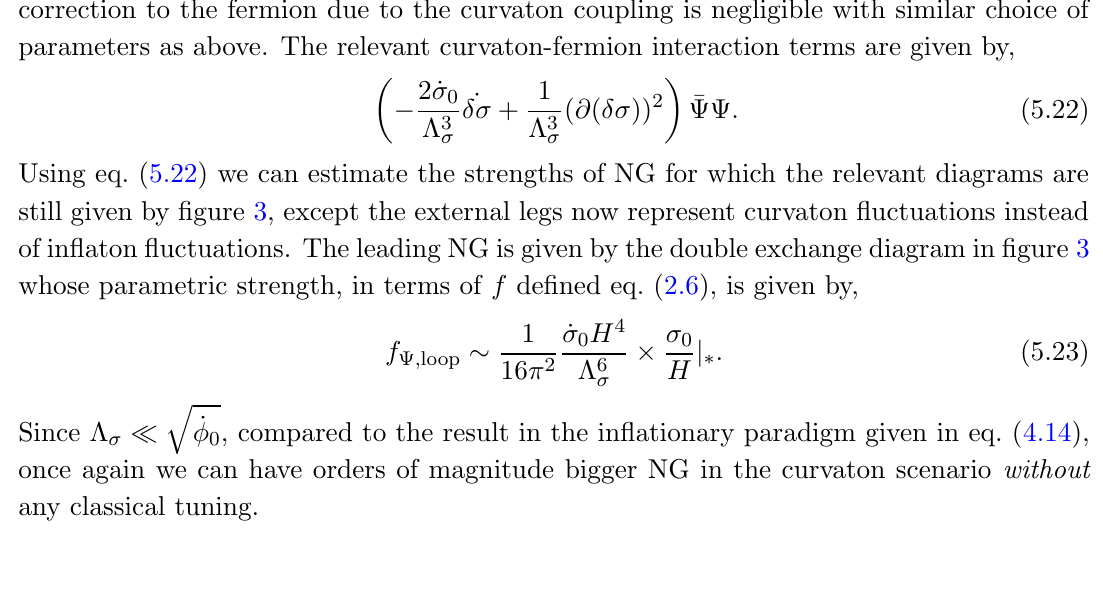
q m 2 =H 2 (cid:0) 9 = 4. In (cid:12)gure 5 we plot the function (cid:31) (cid:31)